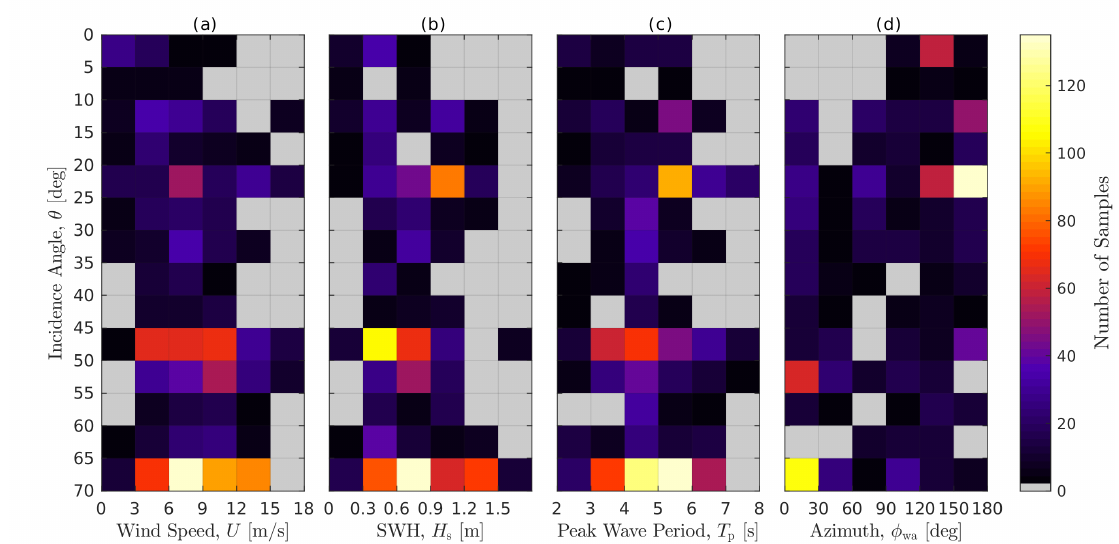
Figure 2. Number of five minute samples for the 2009–2018 data set as a function of incidence angle, θ , and ( a ) wind speed, ( b ) significant wave height (SWH), ( c ) peak wave period, and ( d ) radar-to-wave azimuth (zero is the